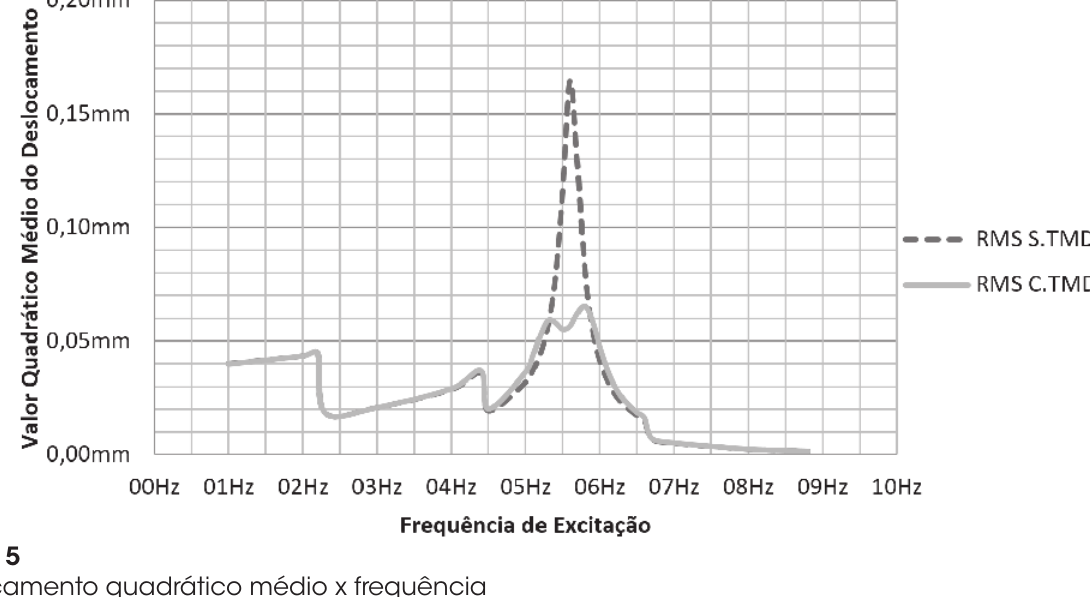
figuras [2] e [3] a seguir representam respectivamente imagens